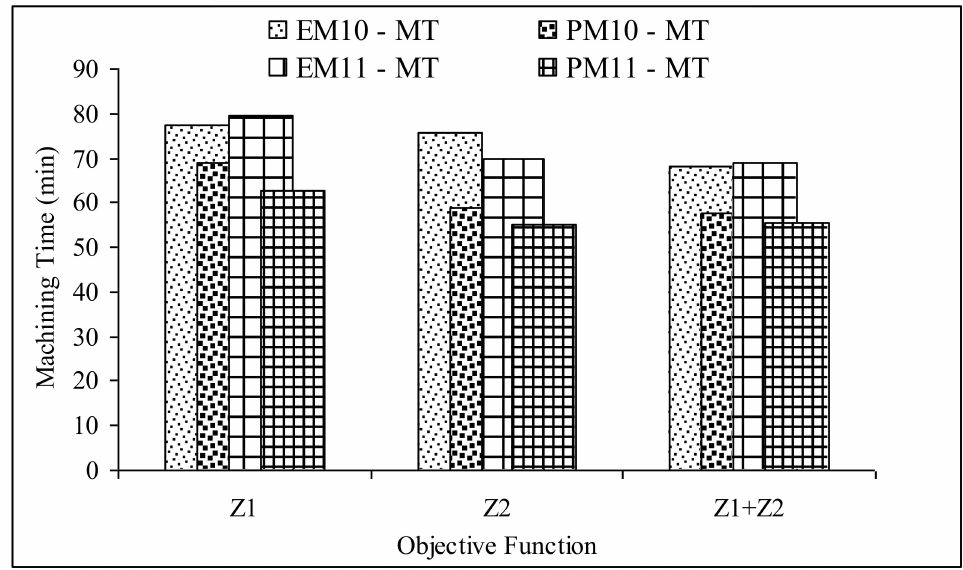
Figure 7. Comparison of machining time of the proposed method with the existing problem presented in Geetha et al. (2013).